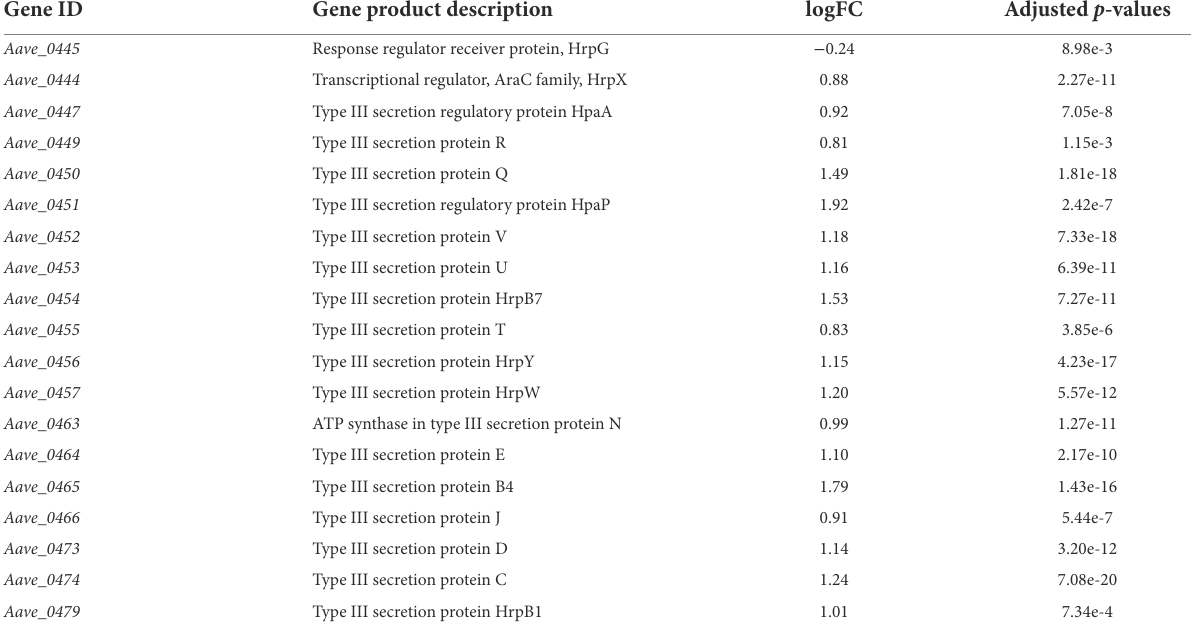
TABLE 3 Differentially expressed type III secretion system genes in Acidovorax citrulli Δ barA Ac compared to wild-type strain Aac5.